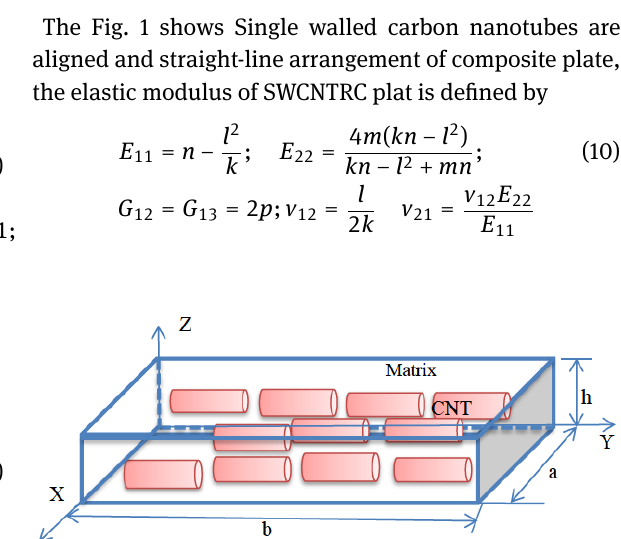
Figure 1: Straight aligned SWCNT, single layered SWCNTRC plate